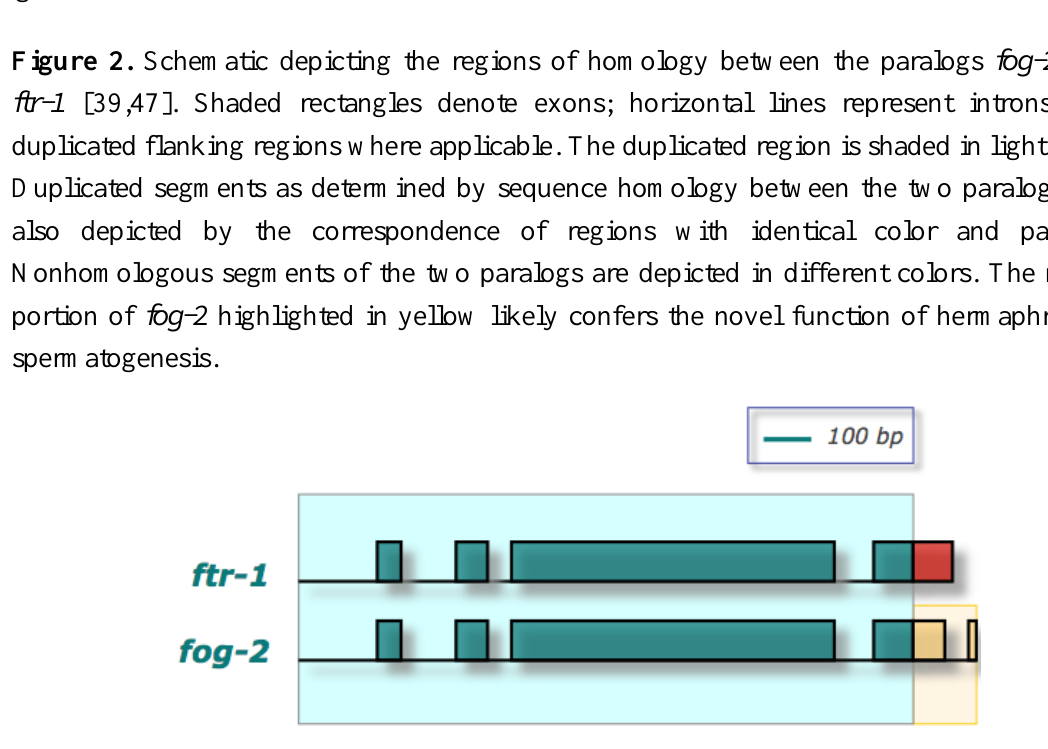
Figure 3. Sequence alignments of in-frame nucleotide positions 200-499 of exon 3 displaying two independent gene conversion events at the fog-2 locus by ftr-1 resulting in a phenotypic alteration from obligate outcrossing to hermaphroditism in two fog-2(lf) q71 mutant lines [39]. The red box displays the nonsense mutation G  A in the fog-2(lf)q71 allele resulting in a nonfunctional gene relative to the wild-type. Regions highlighted in yellow represent the minimum gene conversion tracts by ftr-1 in sex-revertants 1 and 2. Dots represent identical nucleotides to the fog-2 wild-type